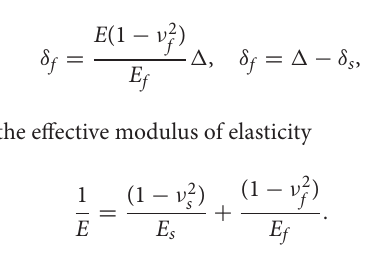
model, (depending on whether the application is displacement controlled or force controlled) the load is applied as the penetration of the indenter to the flat. Figure 9 shows the contact profile for 15 load steps from 1/ R for set 1 used in the initial observations. All of the load steps